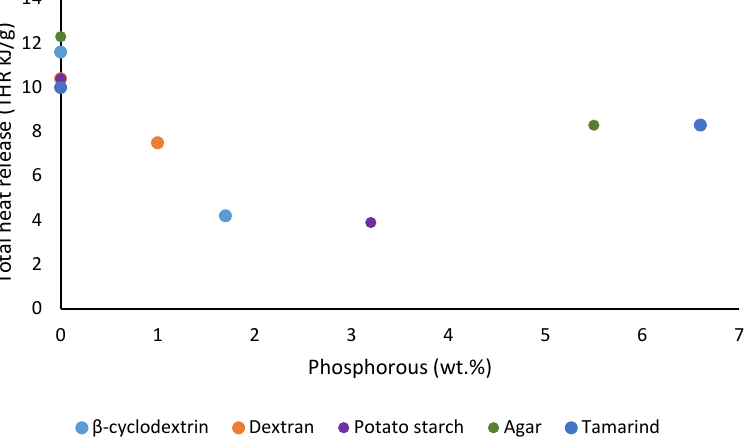
Figure 16. Plot of peak heat release rates (pHRR) versus phosphorus content (wt. %) of the substrates.